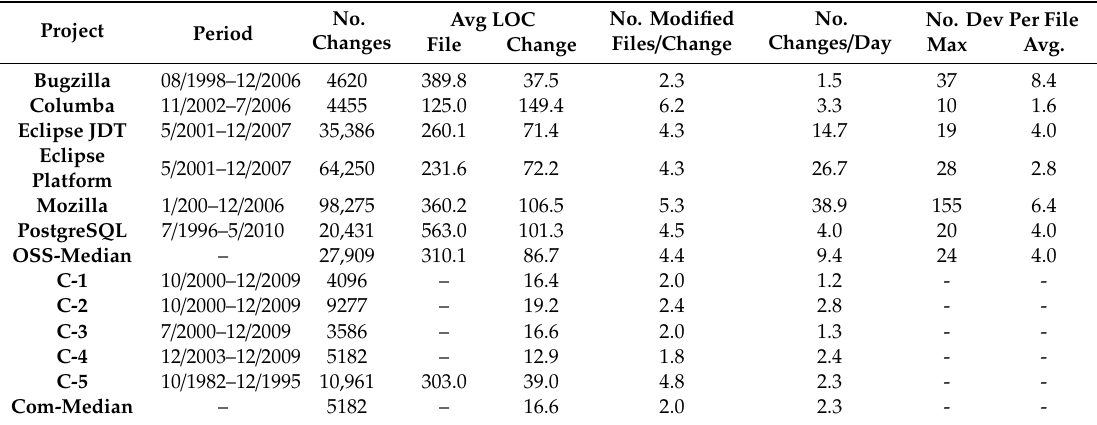
Table 1. Statistic of the projects included in the dataset [15].